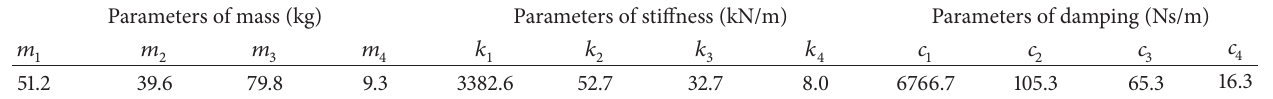
Table 3: Mass, stiffness, and the damping values for the models.